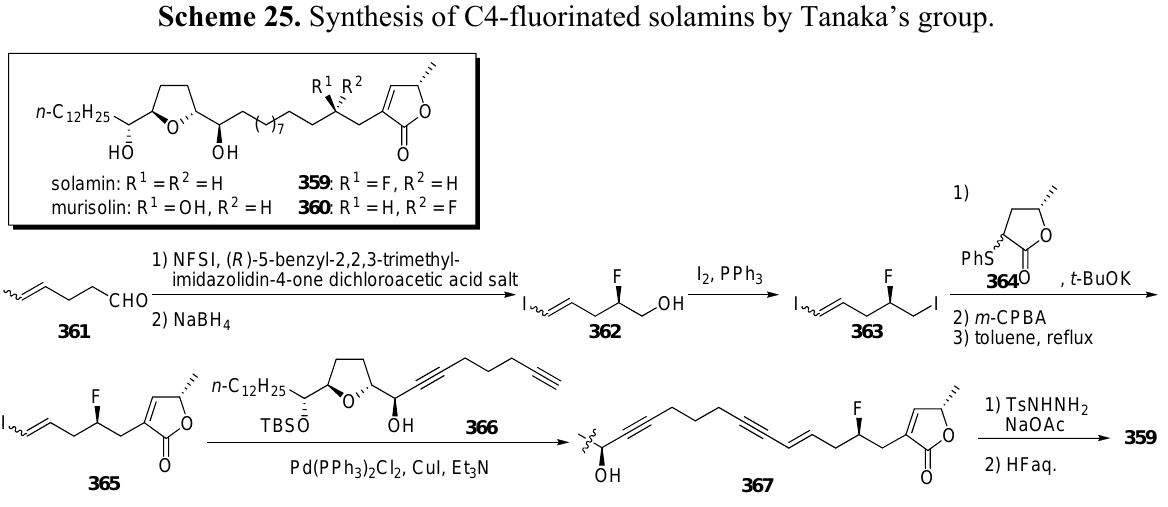
Table 27. Selected GI (M) values of fluorinated analogues against 39 human cancer cell lines. 50 Compounds